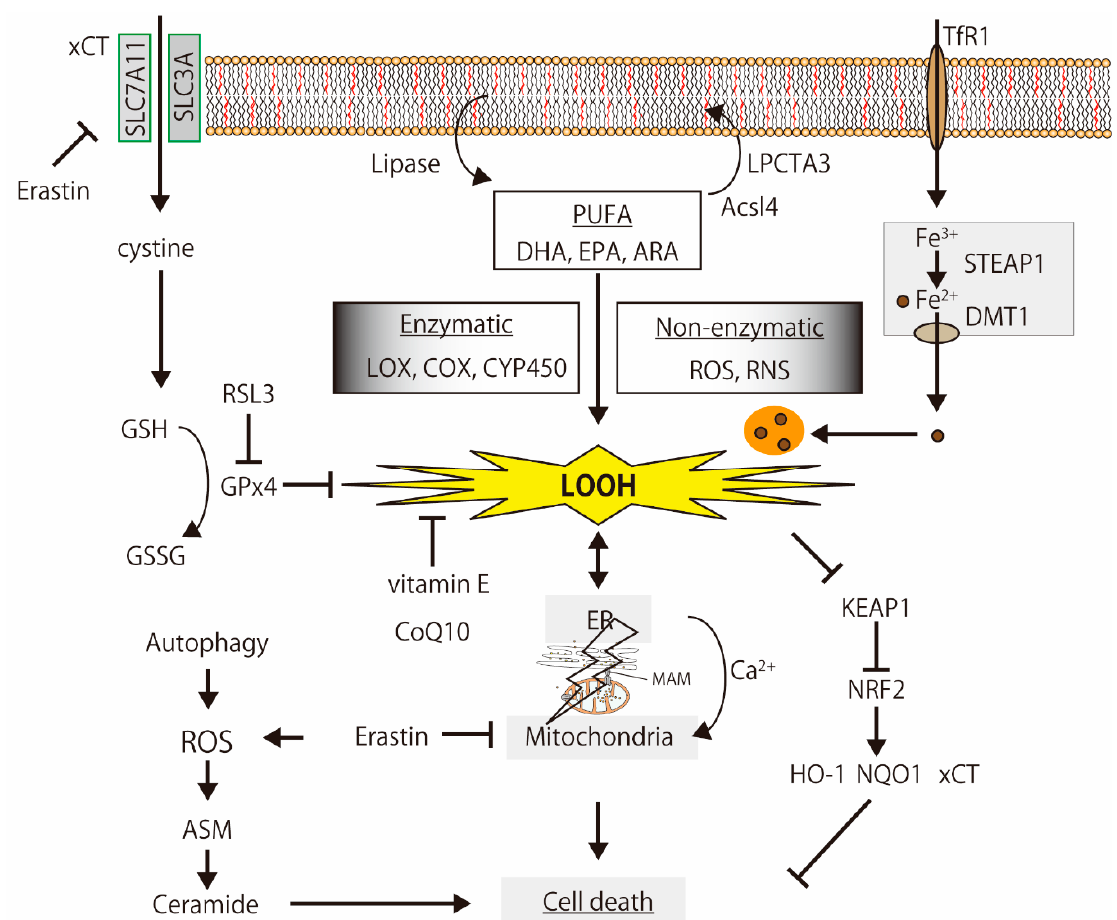
Figure 2. The simplified mechanisms of lipid peroxidation-induced cell death. PUFAs are oxidized by enzymatic and non-enzymatic reactions, and the products induce organelle dysfunction, iron-metabolism disturbance, Ca 2+ -signaling alternation, and cell death, which are regulated by the glutathione (GSH) synthesis signal, antioxidants, and oxidative stress response. The illustration was adapted from Iuchi (2021).